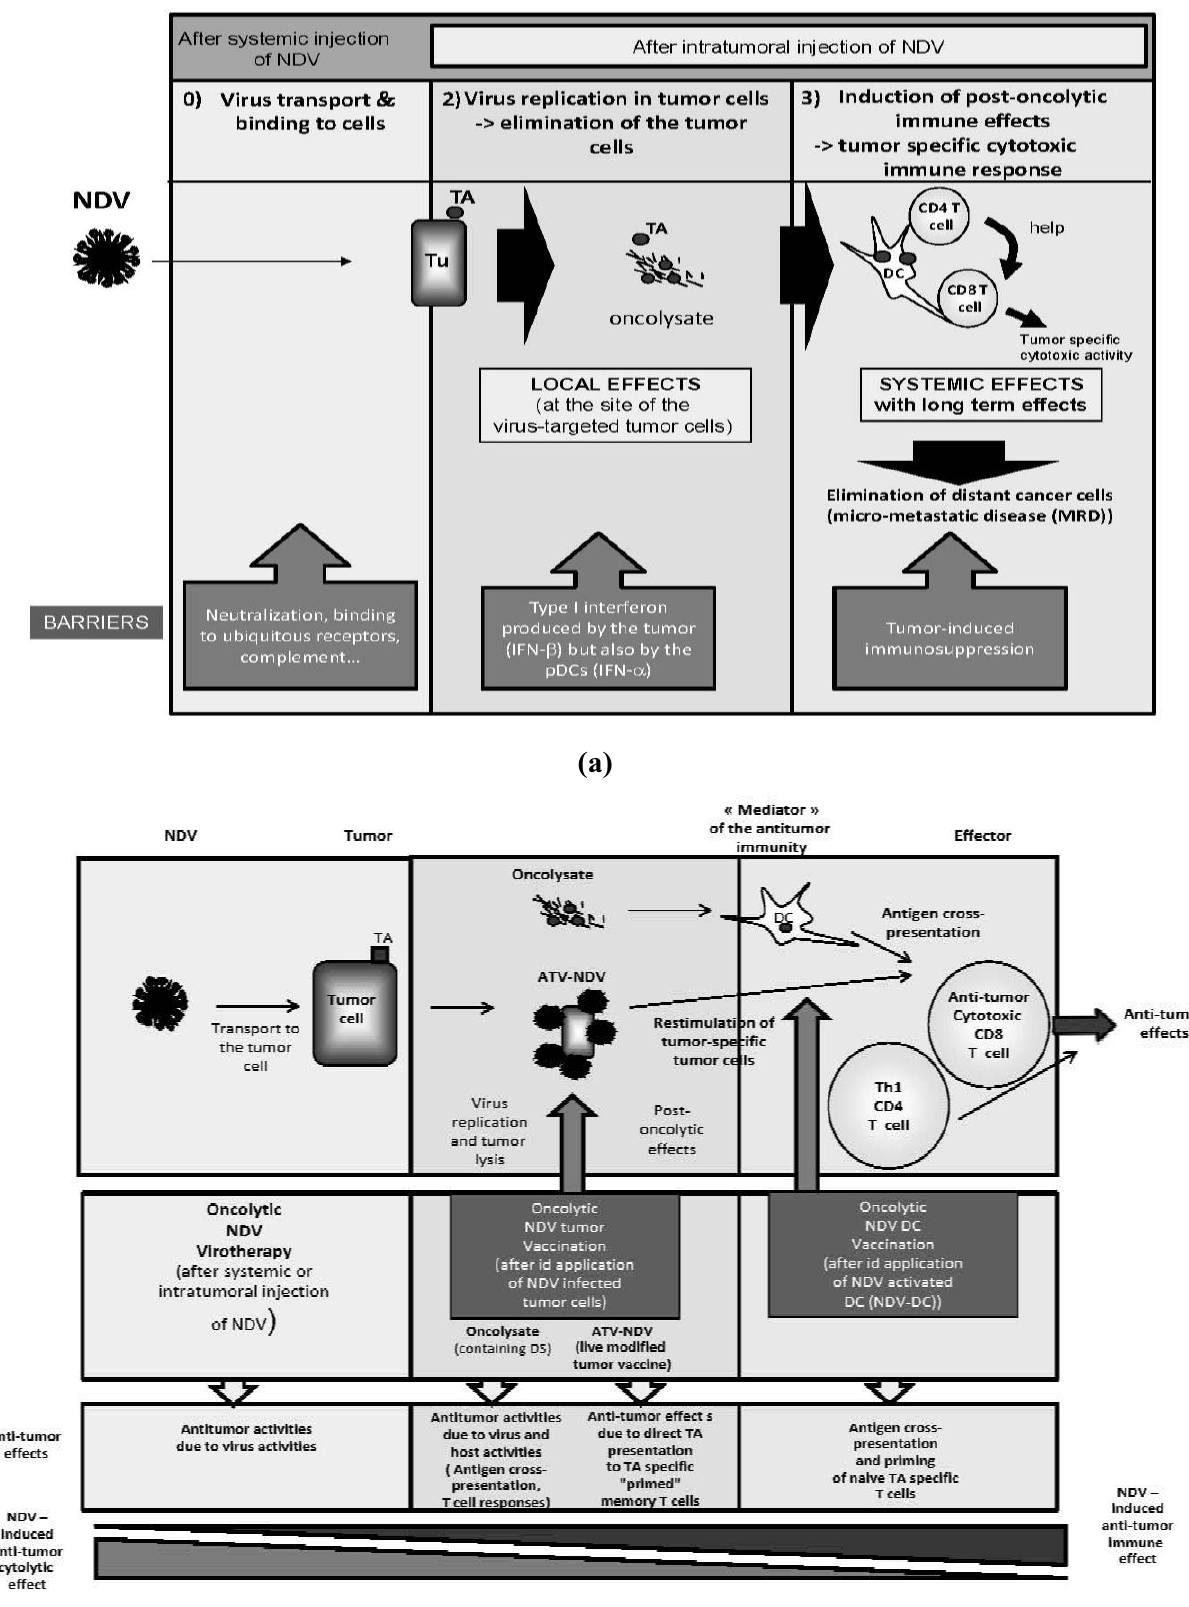
Figure 5. ( a ) The expected three steps after in vivo application of NDV; ( b ) Strategies to enhance NDV-induced anti-tumor immune activities (see the main text for more